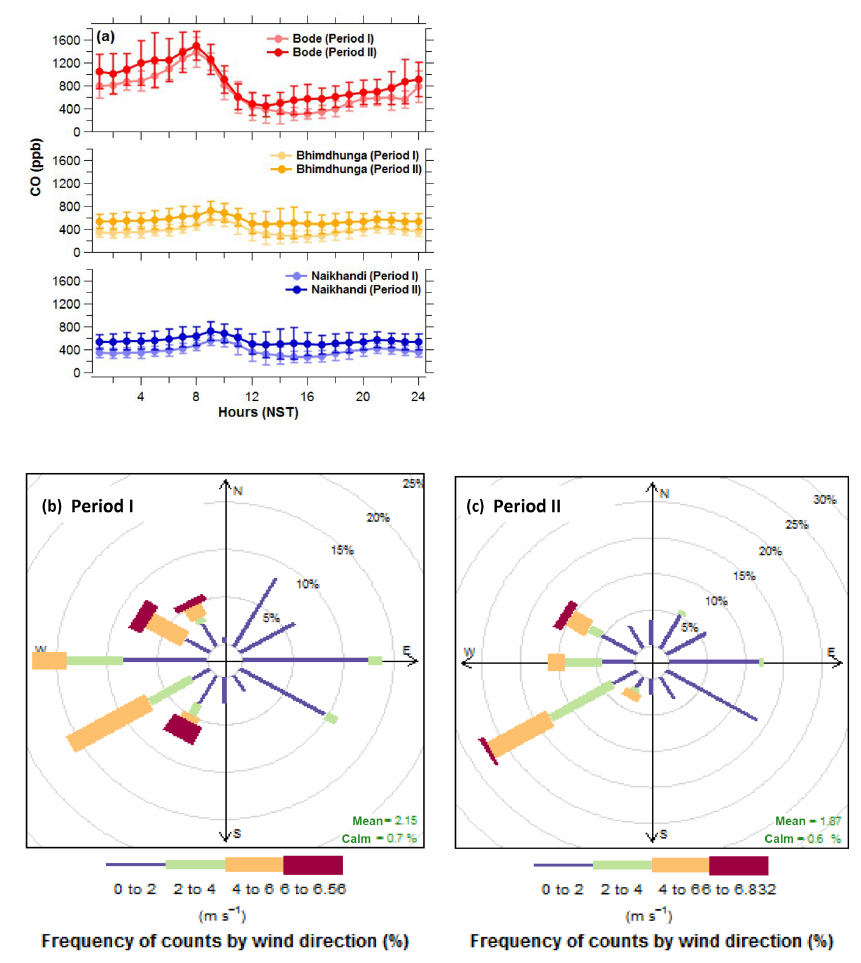
Figure 5. Comparison of hourly average CO mixing ratios during normal days (16–30 March), labeled as period I (faint color), and episode days (1–15 April), labeled as period II (dark color), in 2013 at (a) Bode, Bhimdhunga and Naikhandi in the Kathmandu Valley. The wind roses at Bode corresponding to two periods are also plotted (b) period I and (c) period II